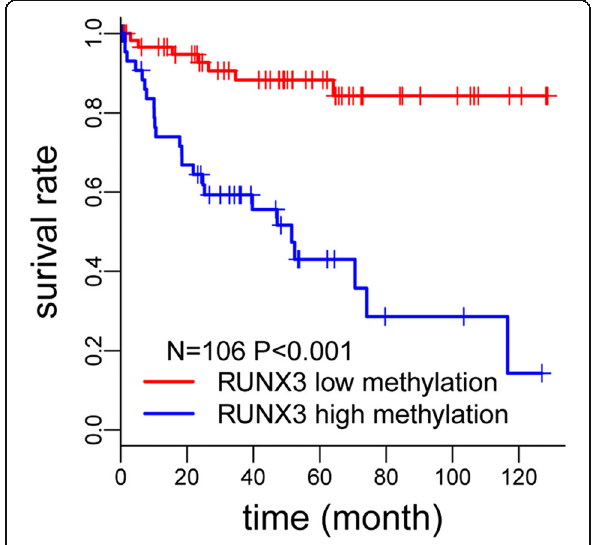
Fig. 7 Univariate Cox regression analysis of prognostic factors for overall survival is summarized. Reprinted with permission from: Cen et al. [116] PubMed PMID: